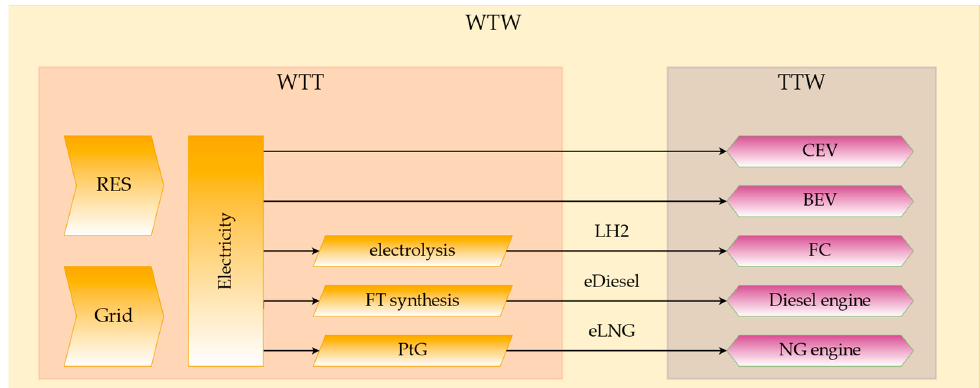
Figure 1. Schematic of the WTW integration process.